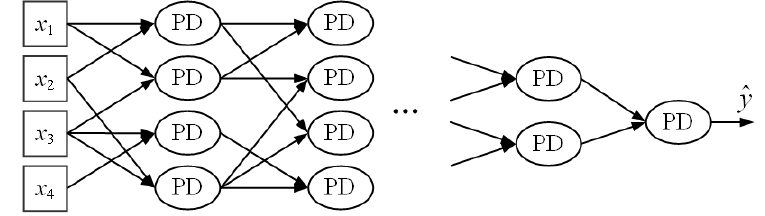
Figure 3. An example of GMDH polynomial network